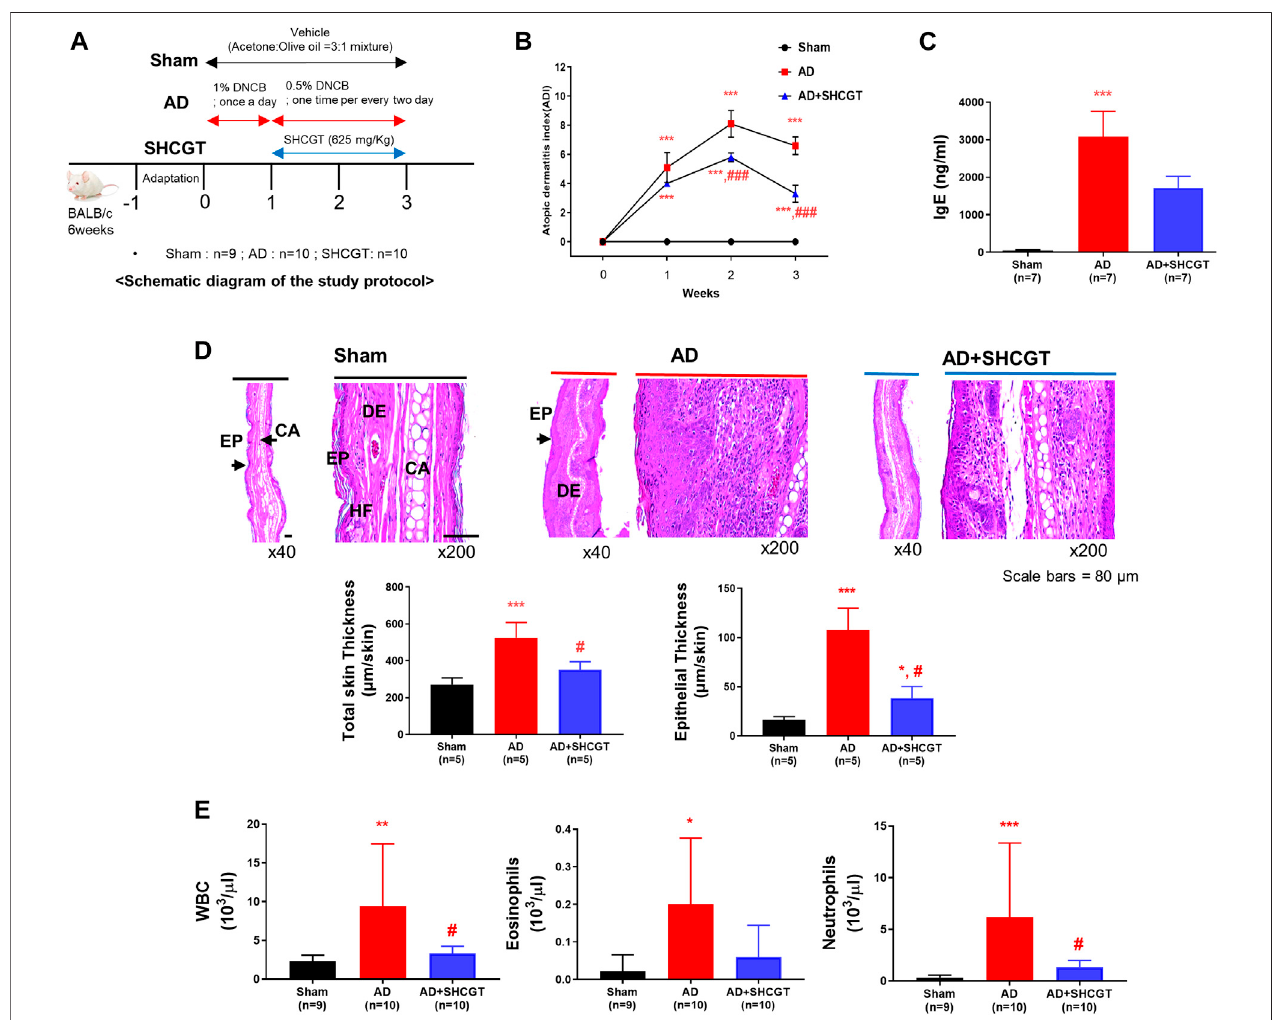
FIGURE 1 | Oral administration of SHCGT suppresses DNCB-induced AD. (A) Timeline for induction ofAD and treatment with SHCGT. (B) The severity of DNCB- inducedADwasevaluatedbasedonfoursymptoms(erythema/edema,pruritus/dryness,erosion,and licheni fi cation)andscoredas0(none), 1(mild), 2(moderate),or3 (severe). (C) Plasma IgE. (D) Ear skin specimens stained with hematoxylin. Total skin and epithelial thickness were evaluated by histological analysis. (E) Total WBC, eosinophil, and neutrophil levels. * p < 0.05, ** p < 0.01, *** p < 0.001 vs. sham; # p < 0.05, ### p < 0.001 vs. AD. AD, atopic dermatitis; DNBC, 2,4- dinitrochlorobenzene; IgE, immunoglobulin E; SHCGT, Sihocheonggan-Tang ; WBC, white blood